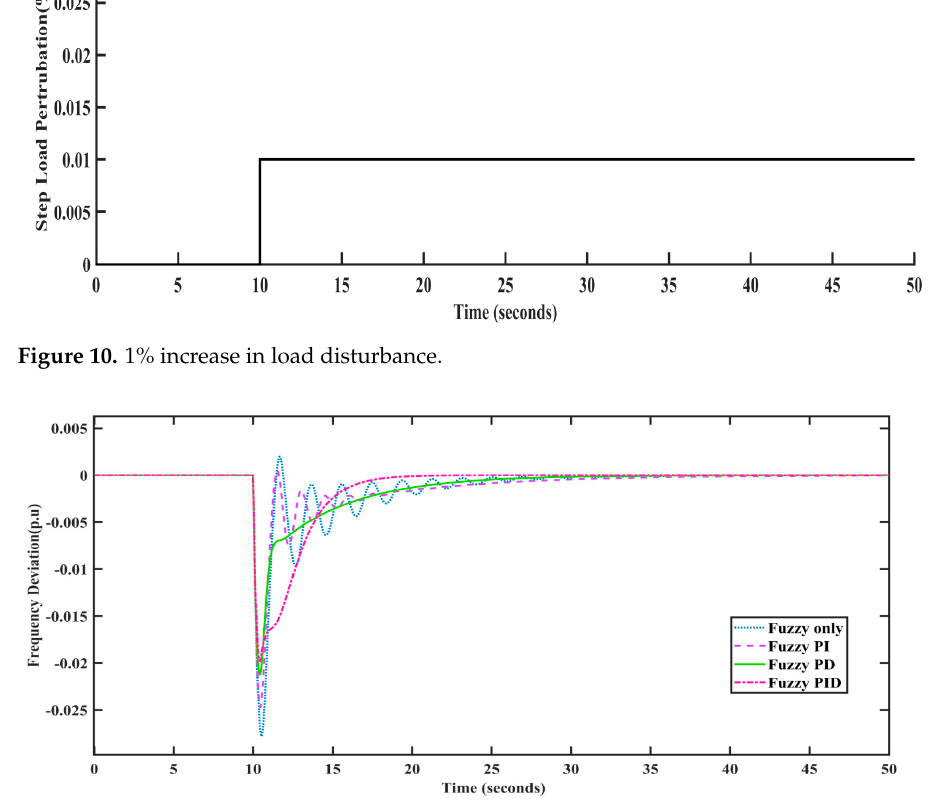
Figure 11. Dynamic response comparison of different control configurations of IHPS frequency change with step input of 1% increase in load. Table 2. Settling time (seconds) for change in frequency and change in power of the hybrid system